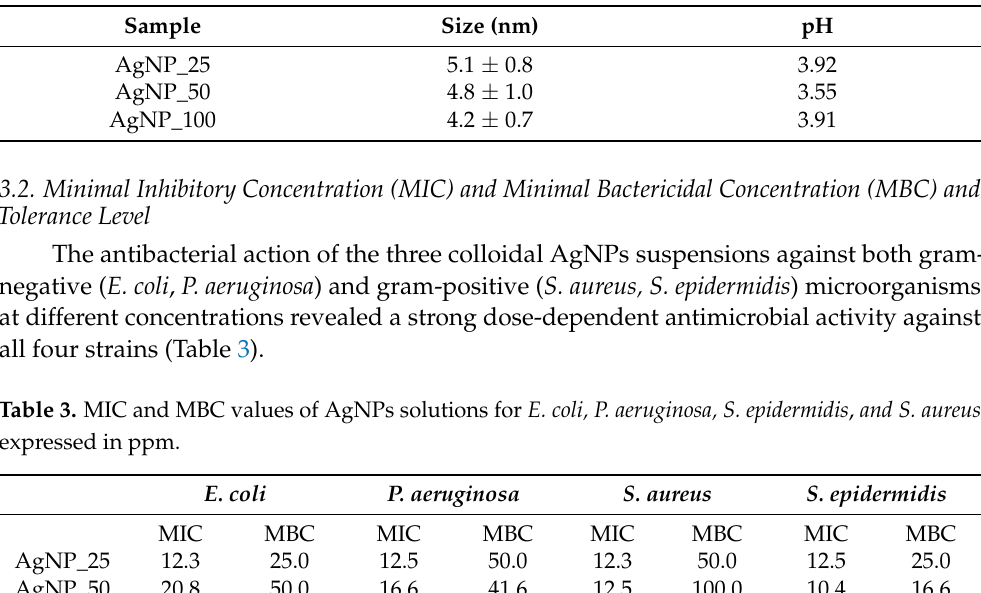
Table 2. Physicochemical characterization of AgNPs.